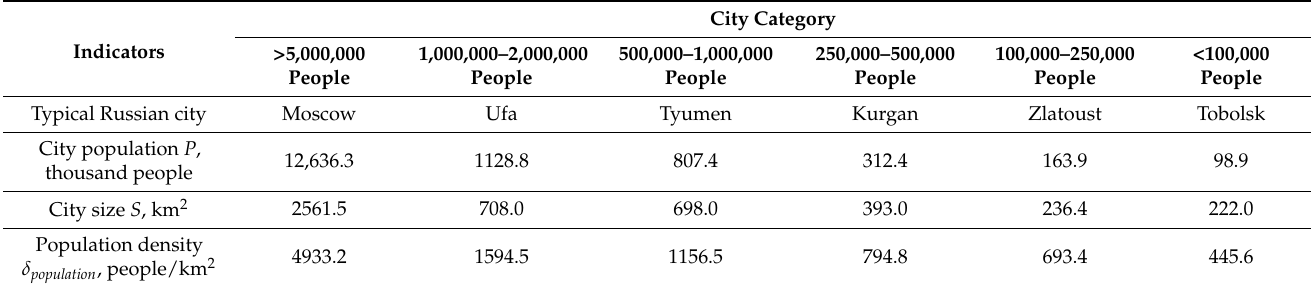
Table 3. Specifics of settlements of citizens in the city space of typical Russian cities